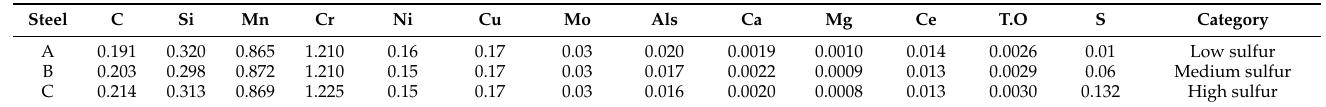
Table 1. Steel composition